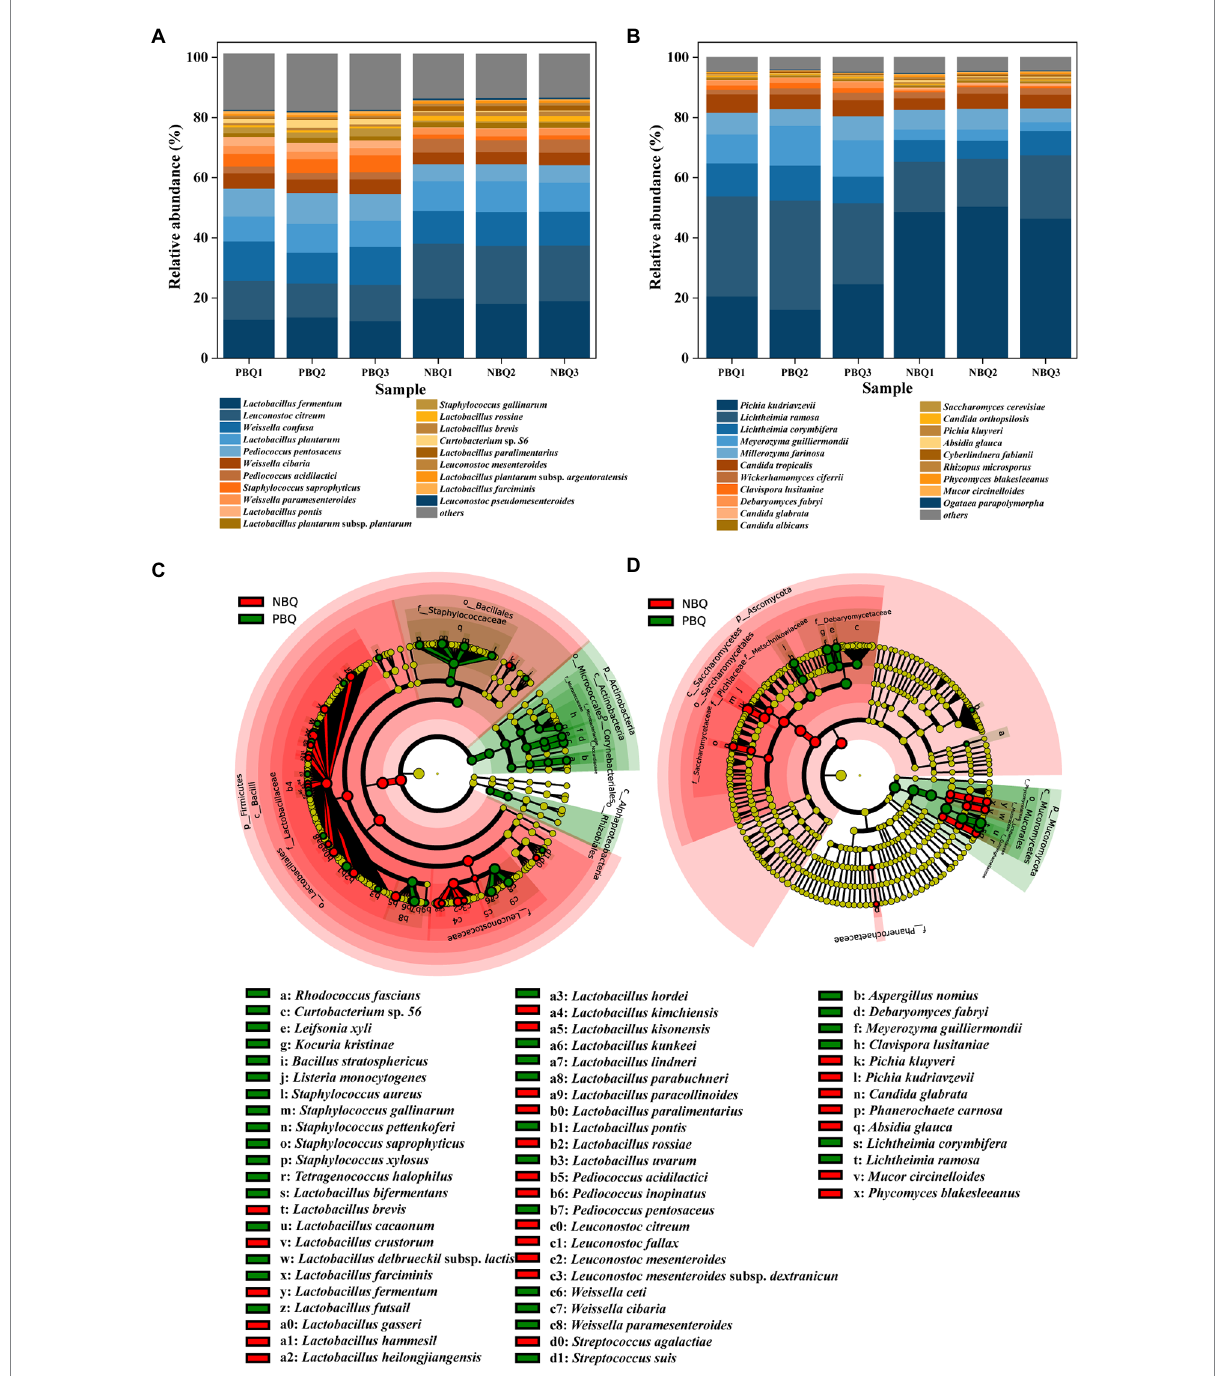
FIGURE 2 Dominant bacteria (A) and fungi (B) at species-level; investigation of bacterial (C) and fungal (D) biomarkers of the two grades of BBQ based on